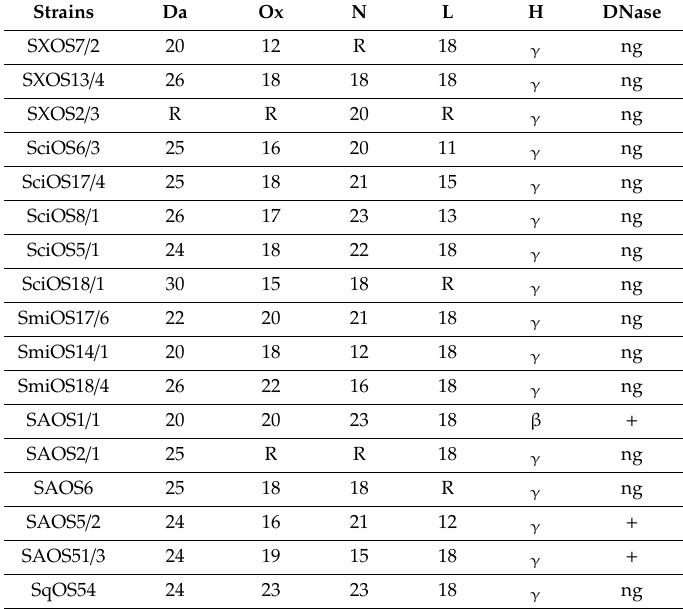
Table 2. Antimicrobial phenotype profile of detected staphylococci, hemolysis, and DNase test. Strains Da Ox N L H